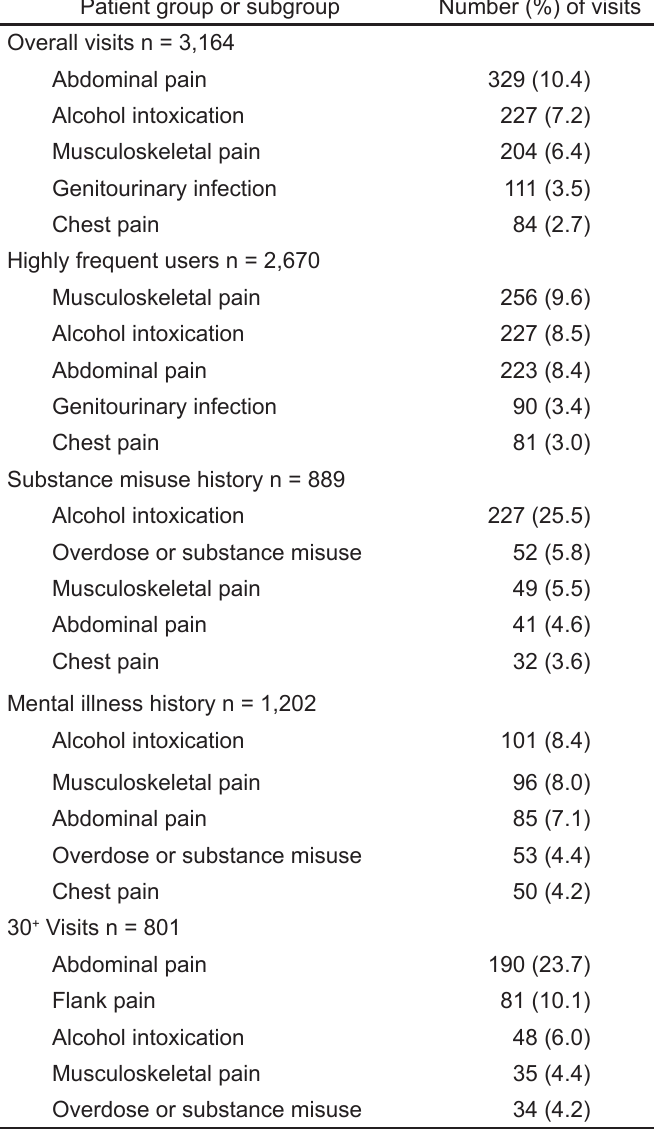
Table 3. Emergency department discharge diagnoses were grouped into appropriate categories.